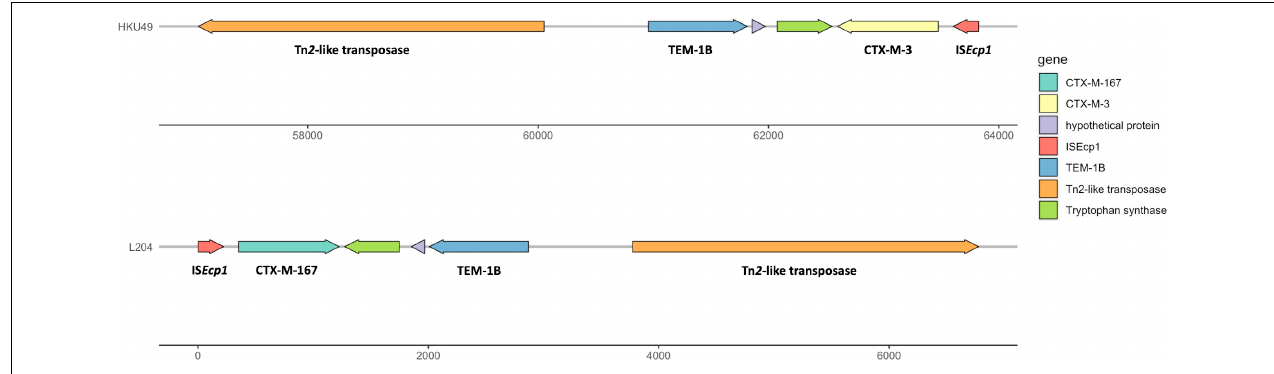
FIGURE 1 | Multidrug resistance region (MRR) of bla CTX − M − 167 in K. pneumoniae L204 and bla CTX − M − 3 in HKU49. Resistance genes are indicated by yellow symbols. Transposon-related genes and insertion sequences are indicated by green symbols. Light gray shading indicated homologous regions ( > 99% DNA